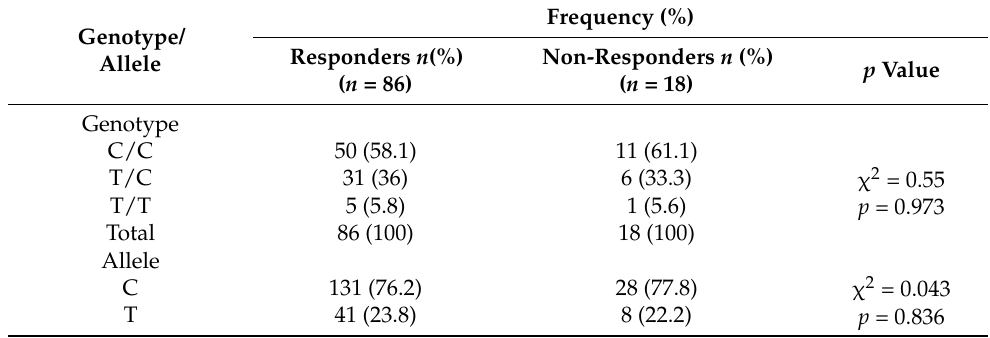
Table 5. Frequency of the CYP4F2 rs2108622 genotypes in the responder and non-responder groups.